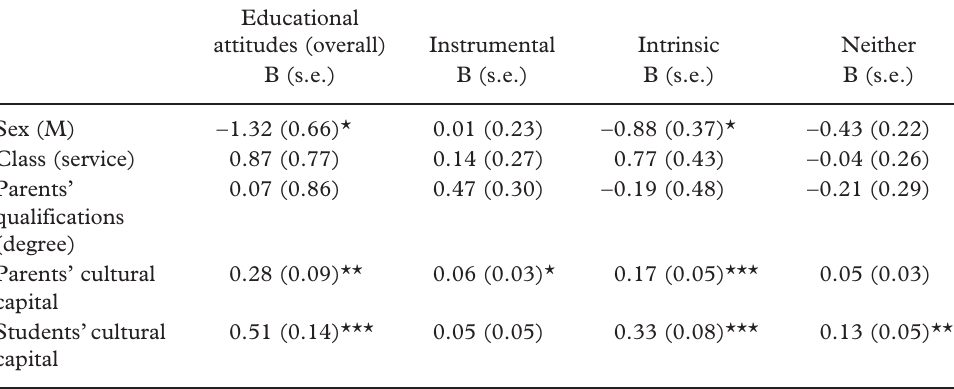
Table 2. tudents’ attitudes to education controlling for GCSE